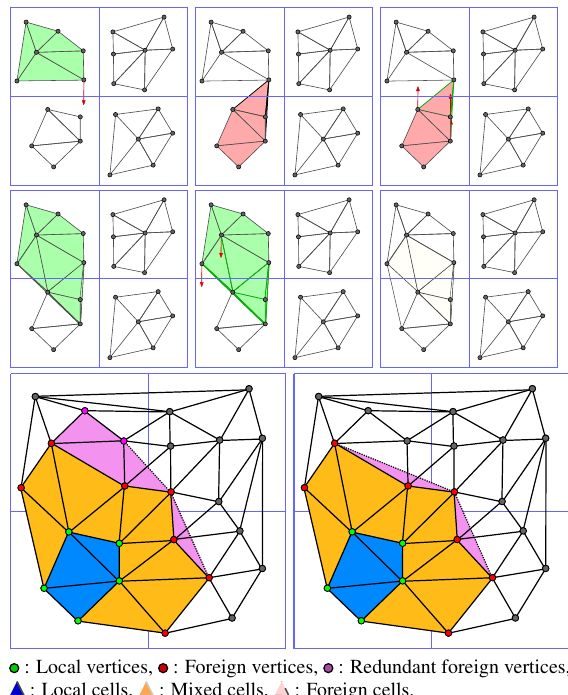
Figure 2. The first two rows show the principle of the algorithm, that iteratively exchange points between tiles. The green and red triangulations exchange points of Delaunay neighbor candidates until convergence. The last row shows the triangulation of the bottom left tile before (left) and after (right)